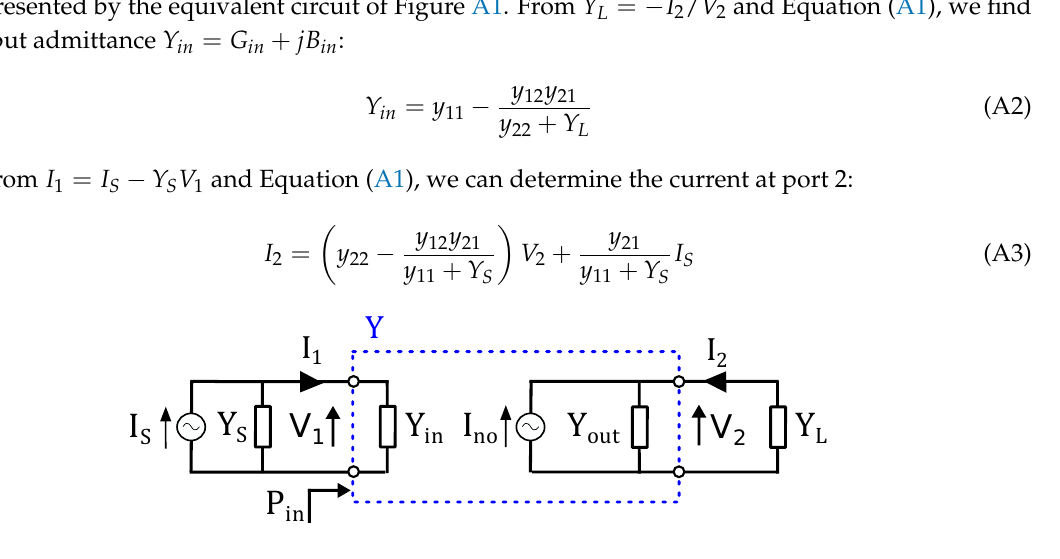
Figure A1. Equivalent circuit of a two-port network with load admittance Y L and current source I S with internal admittance Y S . The input power P in is